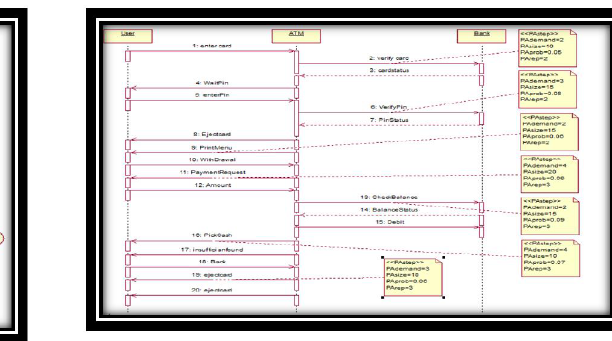
Fig. 4. Use case of ATM Fig. 5. Sequence Diagram for